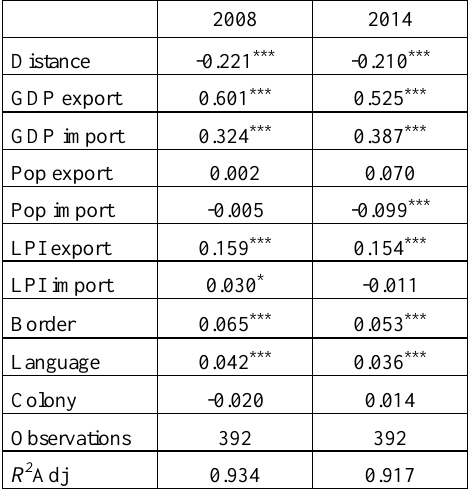
Table 7A: Estimated Coefficients of the Gravity Equation for the Total